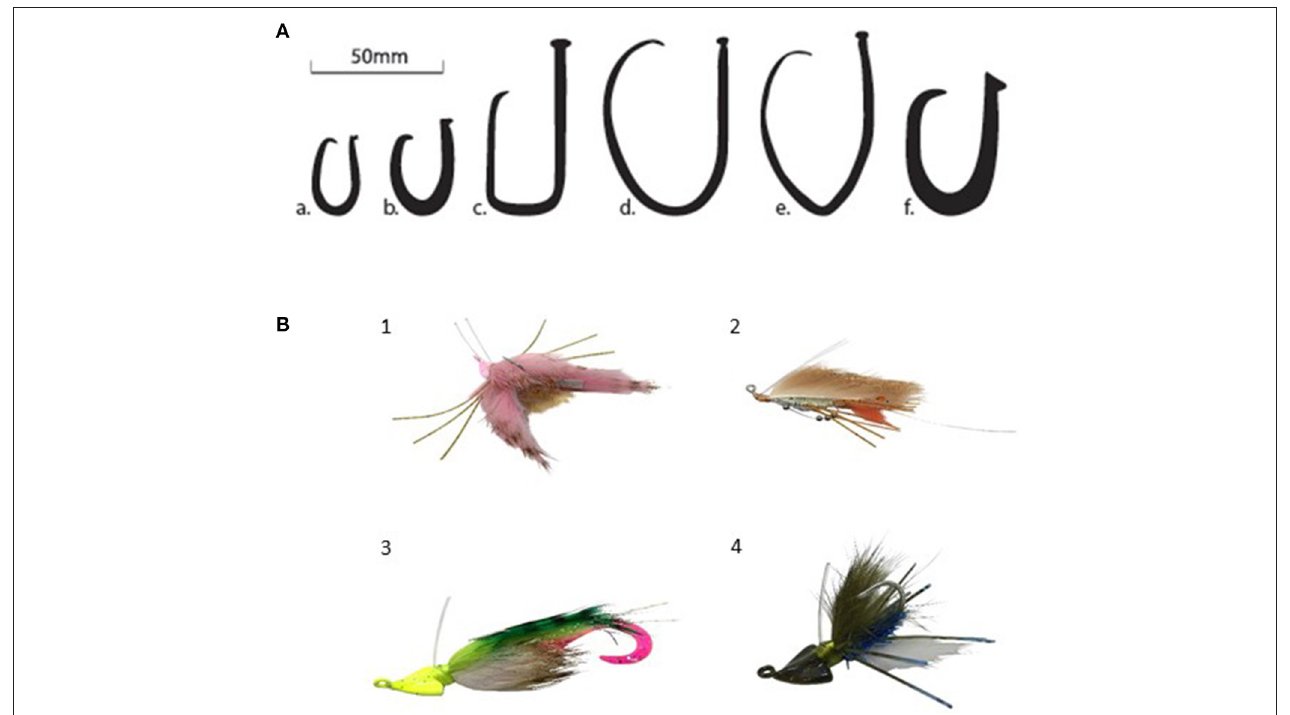
FIGURE 1 | The rate at which fishes learn to avoid fishing techniques such as baits and lures probably reflects both the proportion of the stock that is likely to interact with a fisher and the degree of escapement from the technique. Evidence for this idea is shown by the history of technological innovations in fisheries for species such as bonefishes ( Albula spp., family Albulidae) across the tropical Pacific (Allen, 2014). The line drawings (A) (from photographs in Allen, 2014) show bonefish hooks from indigenous fisheries in the Cook Islands. These include hooks manufactured from pearl shell between thirteenth and sixteenth centuries AD (a,b) and recovered from excavations of rock shelters at Aitutaki Island, southern Cook Islands, metal bonefish hooks collected at Aitutaki Island in early twentieth century (c) and in the same location in the late twentieth century (d, e) and a shell bonefish hook (f) collected in early twentieth century in the northern Cook Islands. Note the consistency